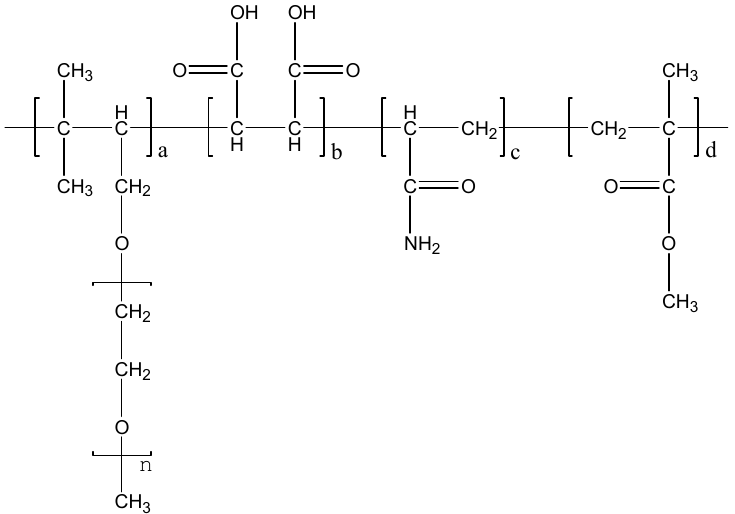
Figure 1. The synthesized formula of polycarboxylate superplasticizers (PCEs).